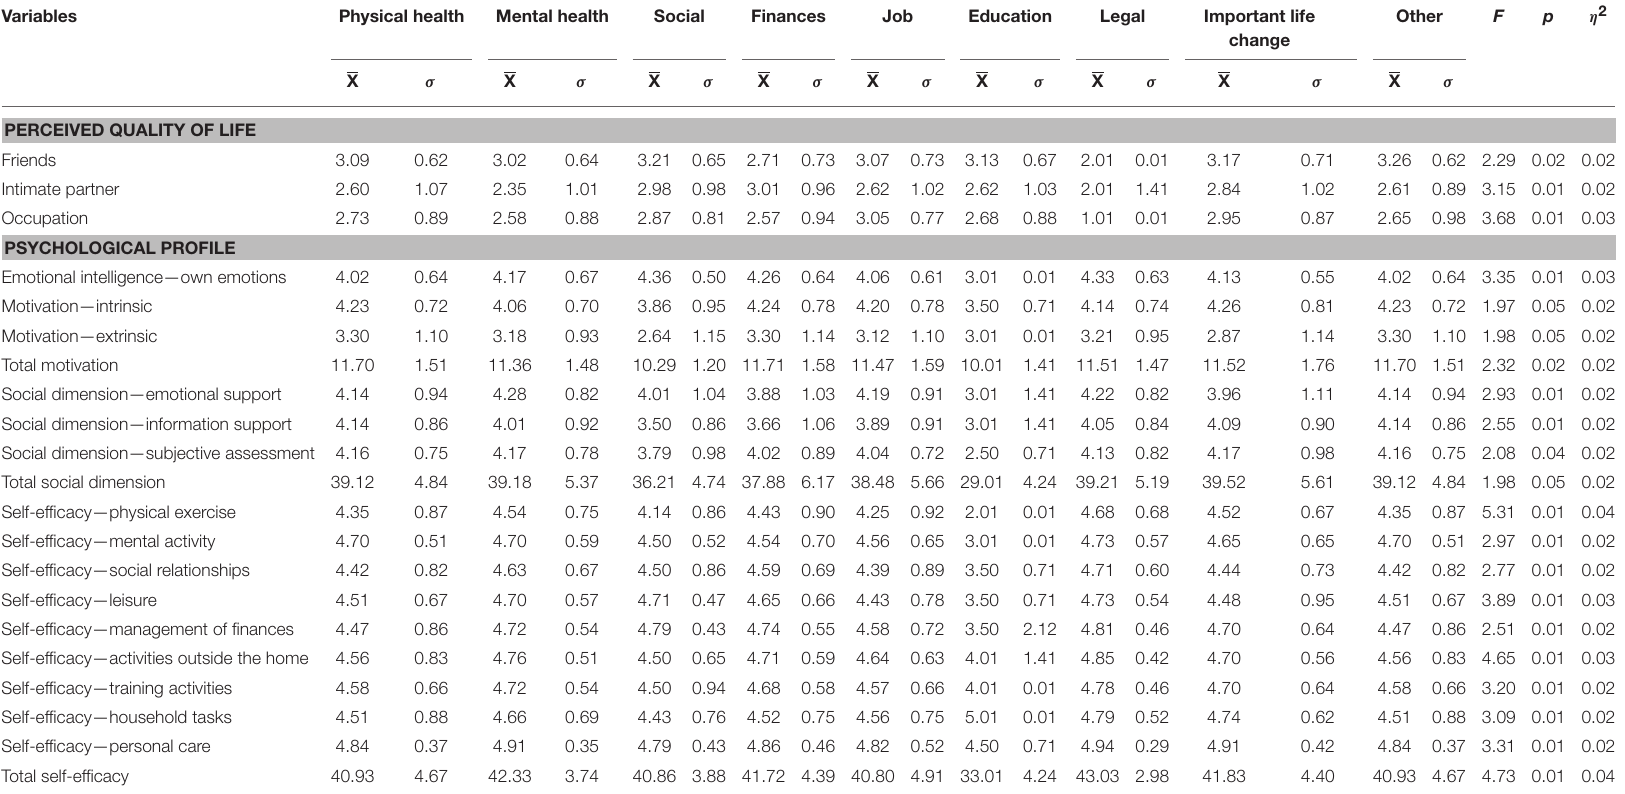
TABLE 2 | Differential patterns in perceived quality of life and psychological profiles according to favorable life experiences.